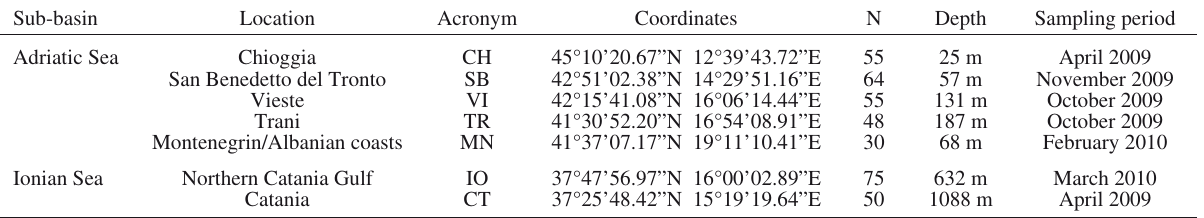
Table 1. – Sampling locations with geographical coordinates, number of individuals analysed and depth at bottom of the sampling area. Sub-basin